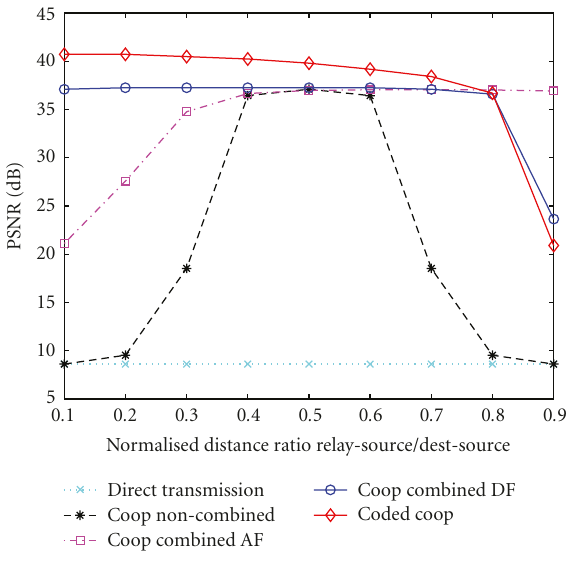
Figure 5: RS Code Rate for Cooperative Protocol with Parity